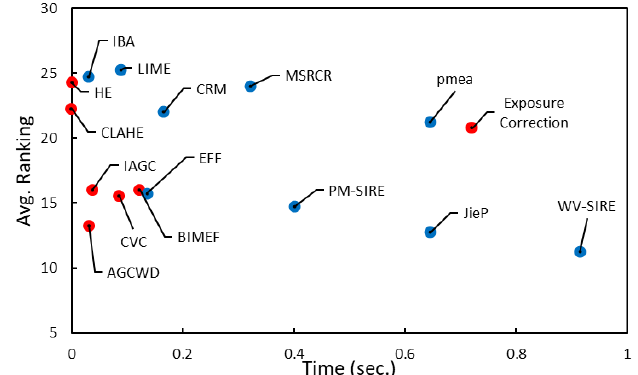
Figure 3. Different IQA metrics are used to rank the enhancement methods. Rank values range from 1 to 31. A rank value of 1 indicates the highest performance based on a particular IAQ method, and a rank value of 1 indicates the worst performance. The average rank is shown in red.